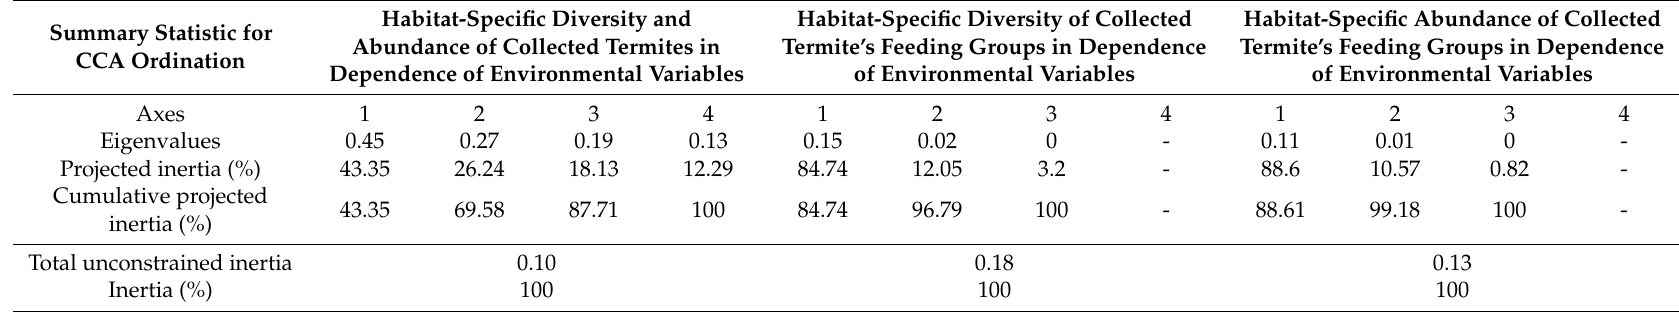
Table 4. Summary statistic for the Canonical Correspondence Analysis (CCA) ordination of termites’ species and feeding groups diversities and abundance as a dependence of environmental